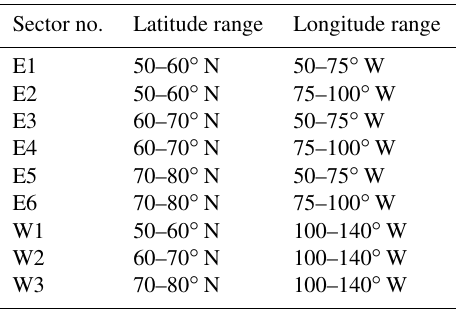
Table 5. Division of geographical sectors over the Canadian Arctic and northern regions for the assessment. Sector no. Latitude